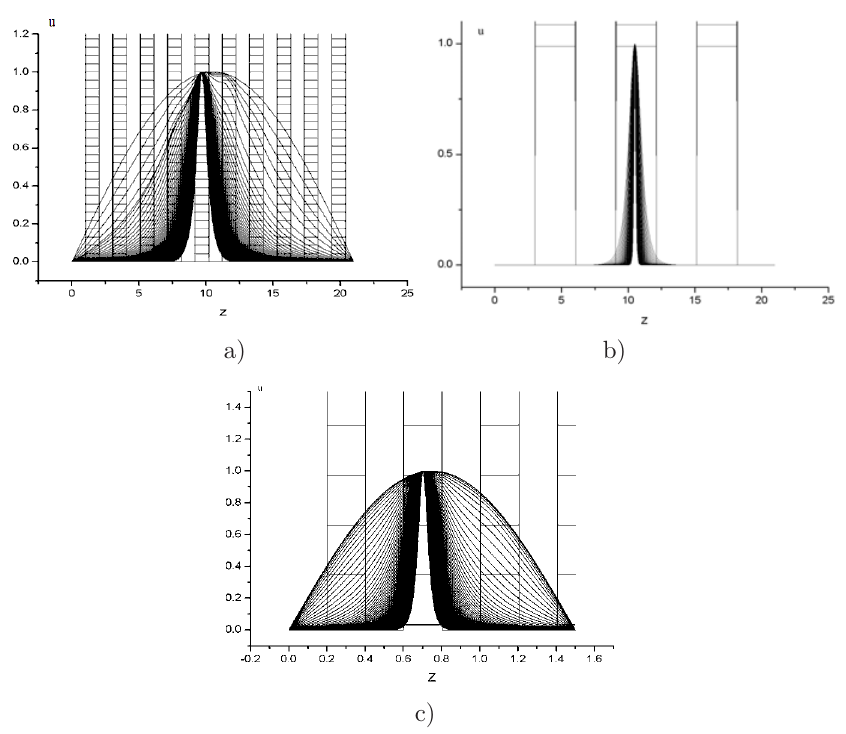
Figure 2. Dependence of EF profile on | α 2 | (a) or on Ω (b, c) at increasing of | α 2 | from 0 to 40 (a) and at increasing of Ω from 1 to 11 (b) or from 0.01 to 10 (c). Other parameters are the following Ω = 1 / ( 4 π ) , α 1 = 0 , ε 1 = 1 . 3 ,ε 2 = 2 . 3 ,d 1 = d 2 = 1 . 0 ,L = 21